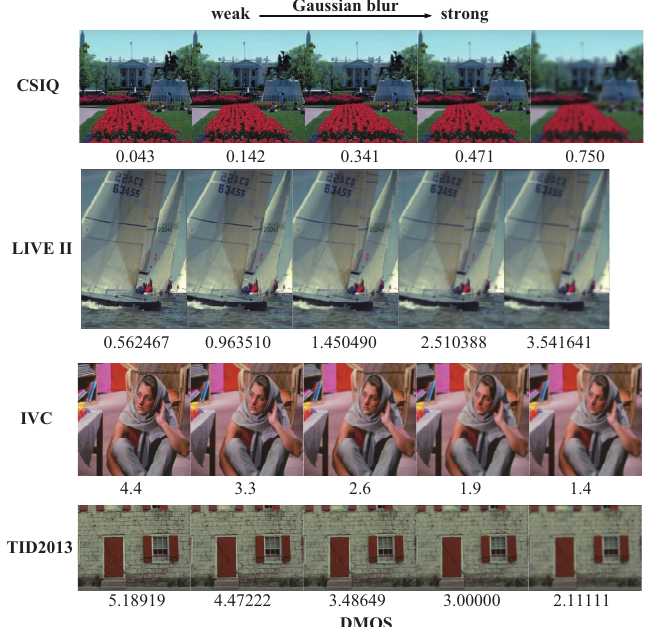
Figure 6. Sample images in the four datasets together with their subjective DMOS scores. Each set of images contains five Gaussian blur images those have gradient DMOS